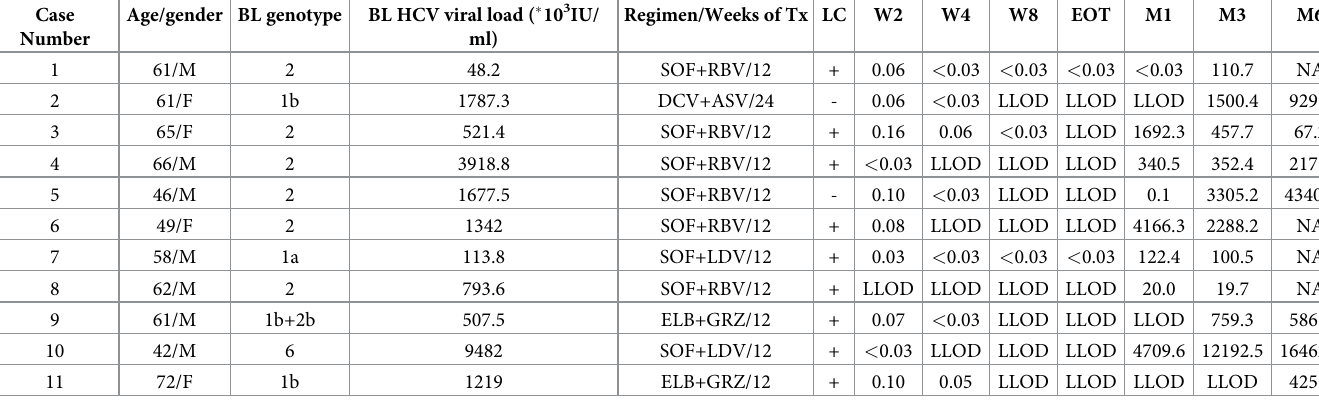
Table 2. Characteristics and serial viral kinetics of the patients with virological failure.